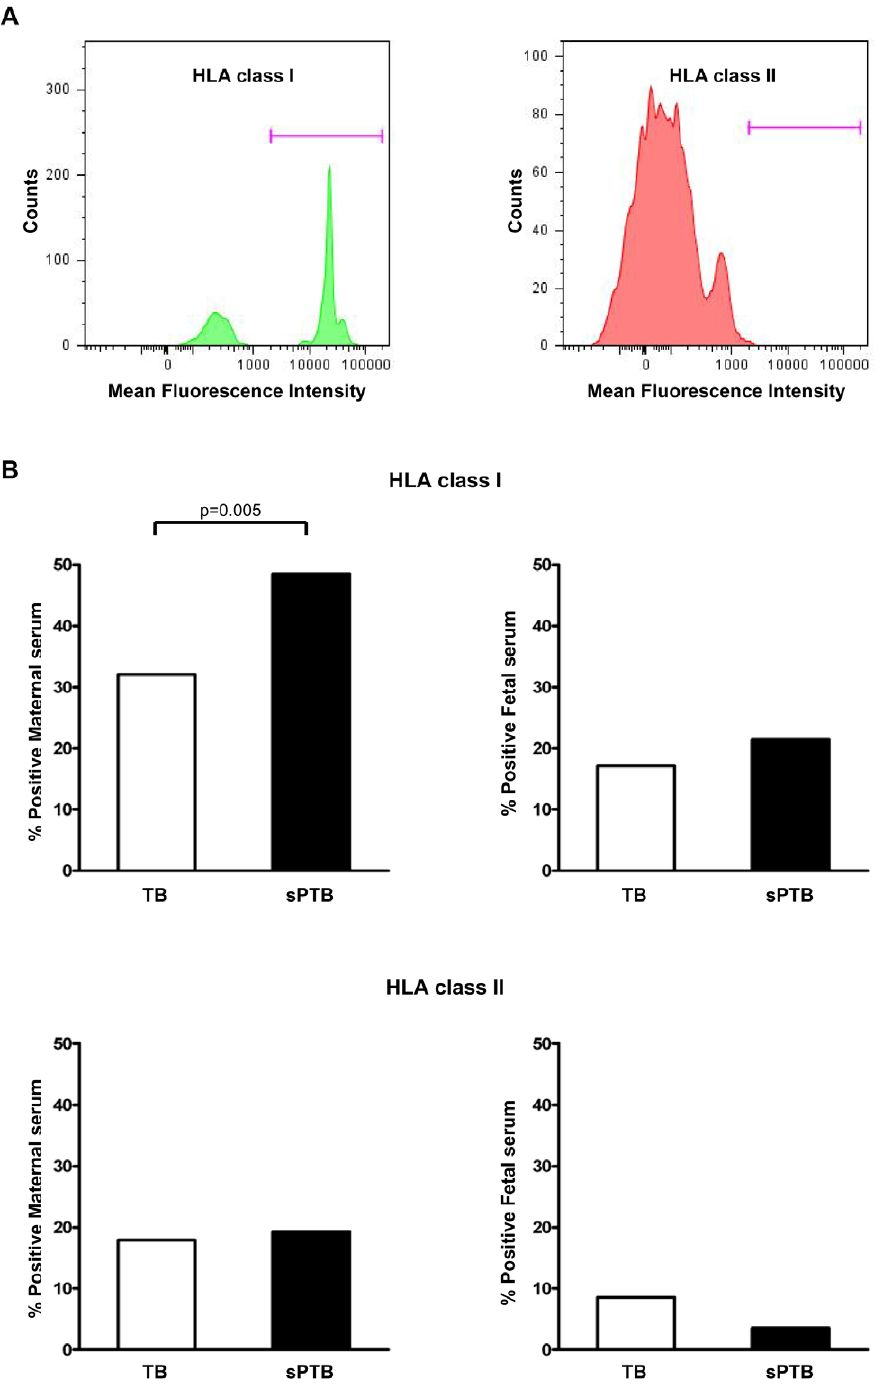
Figure 2. Panel-reactive anti-HLA seropositivity in maternal and fetal sera. (A) A representative case showing the presence of anti-HLA class I antibodies and the absence of anti-HLA class II antibodies in maternal serum with FlowPRA H -I and -II screening tests, followed by flow cytometry. (B) Spontaneous preterm birth cases have a higher maternal anti-HLA class I seropositivity than normal term birth cases (p , 0.01). TB , normal term birth; sPTB , spontaneous preterm birth.